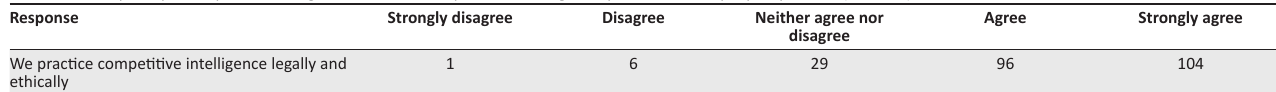
TABLE 11: Frequency of responses to legal and ethical competitive intelligence practice in the property sector ( N = 239).